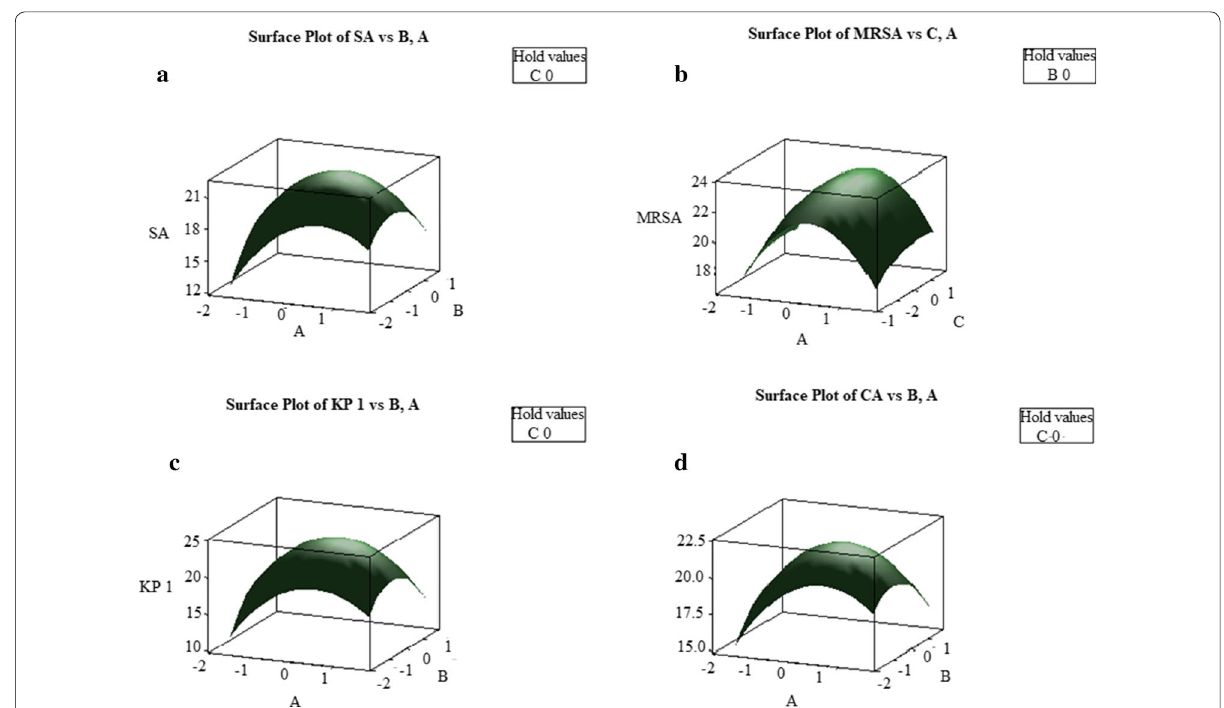
Fig. 8 Response surface plots of a S. aureus , b MRSA, c K. pneumoniae 1 , d C.